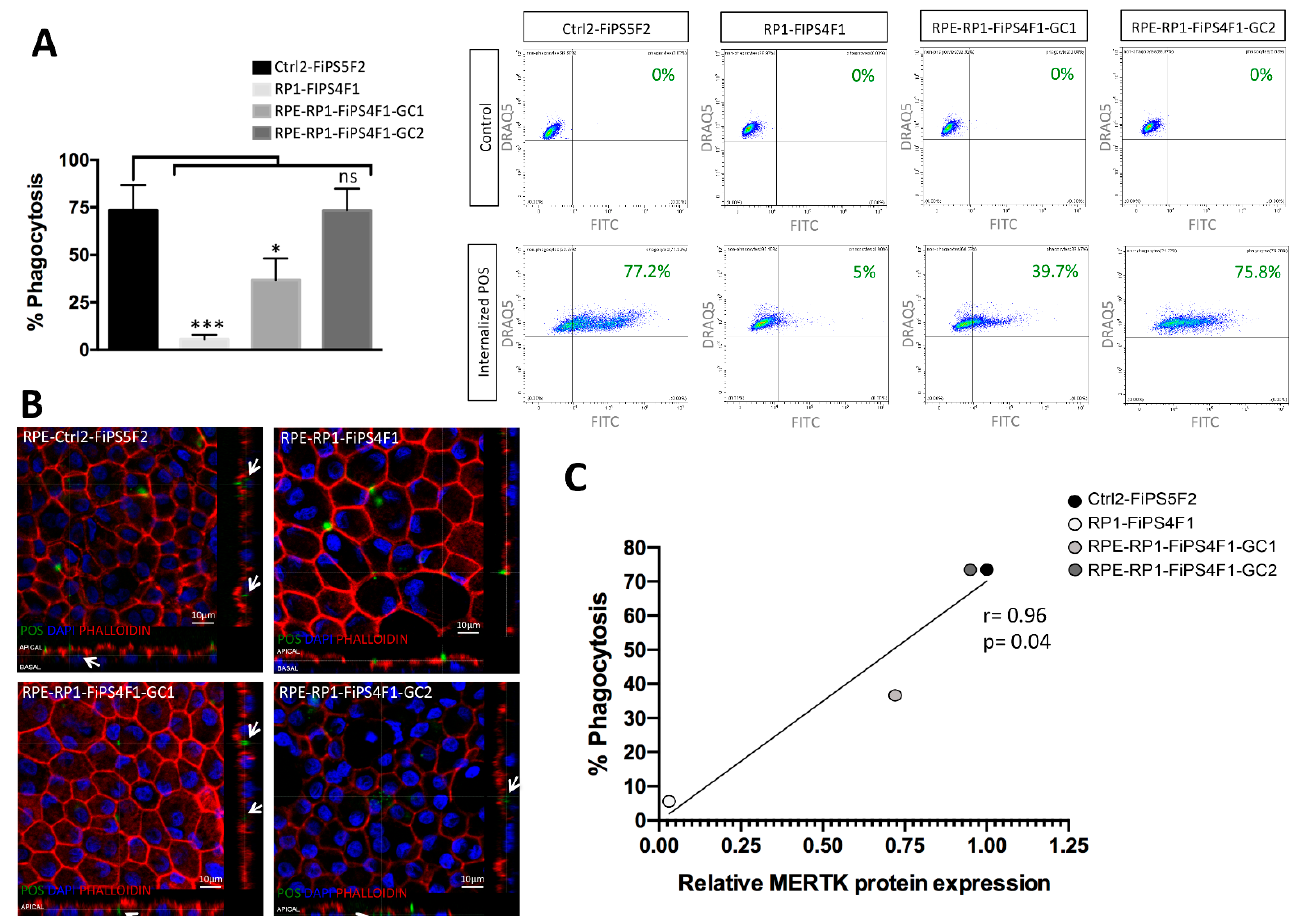
Figure 4. Recovery of photoreceptor outer segments (POS) phagocytosis shown by in vitro phagocytosis assay of POS in hiPSC-RPE. (A) Quantification of phagocytosis assay by flow cytometry. The graph represents the percentage of phagocyte cells of four hiPSC-RPE lines relative to their control (cells without incubation with POS-FITC). Each bar represents the average ± SEM of at least three independent biological replicates. The differences in % of phagocytes between the hiPSC-RPE were tested for significance (* p ≤ 0.05, *** p ≤ 0.001). The plots shown the results of one experiment. Cells with internalized POS-FITC (phagocytes) are placed in the upper right quadrant (DRAQ5 and FITC positive cells). (B) Confocal images of phagocytosis assay show basolateral sections across the hiPSC-RPE together with vertical section simulation. The control hiPSC-RPE and corrected RP-hiPSC-RPE internalize FITC labeled POS (green) (arrows), while the uncorrected RP-hiPSC-RPE do not. F-actin is stained by phalloidin (red) to visualize cell boundary. Images were taken with Leica confocal microscope TCS SP8 using HCX PL APO lambda blue 63X/ 1.4 OIL objective, scale bar 10 µm. ( C ) The Pearson correlation analysis was calculated to evaluate the link between relative MERTK protein expression and the percentage of RPE cells that phagocyte, and there is a significant and strong positive linear correlation between both parameters (r = 0.96; p = 0.04).